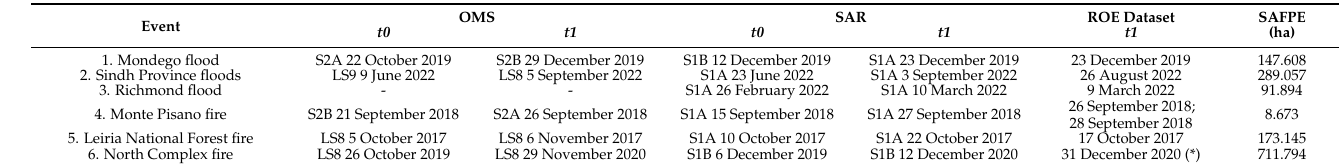
Table 2. Pre- ( t0 ) and post-event ( t1 ) scenes processed with the OMS and SAR modules of the MINDED-FBA tool, for every case study event, alongside with the Reference Observed Event (ROE) dataset t1 date and the study area feature processing extent